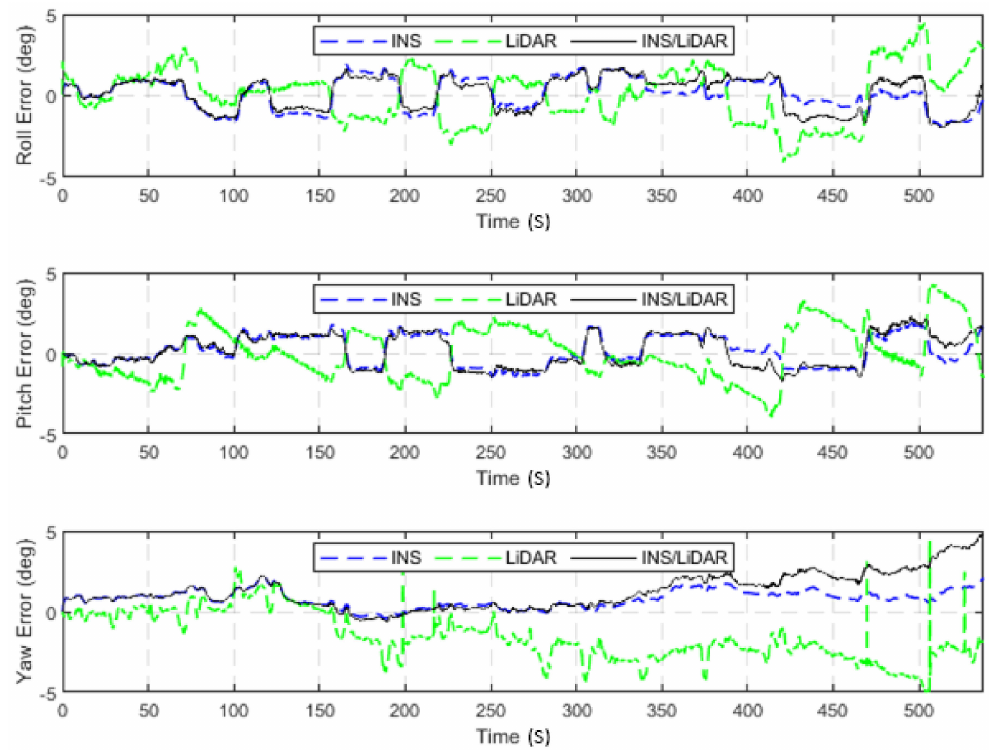
Figure 7. D-28—complete GNNS signal outage: errors of attitude angles (roll, pitch, and